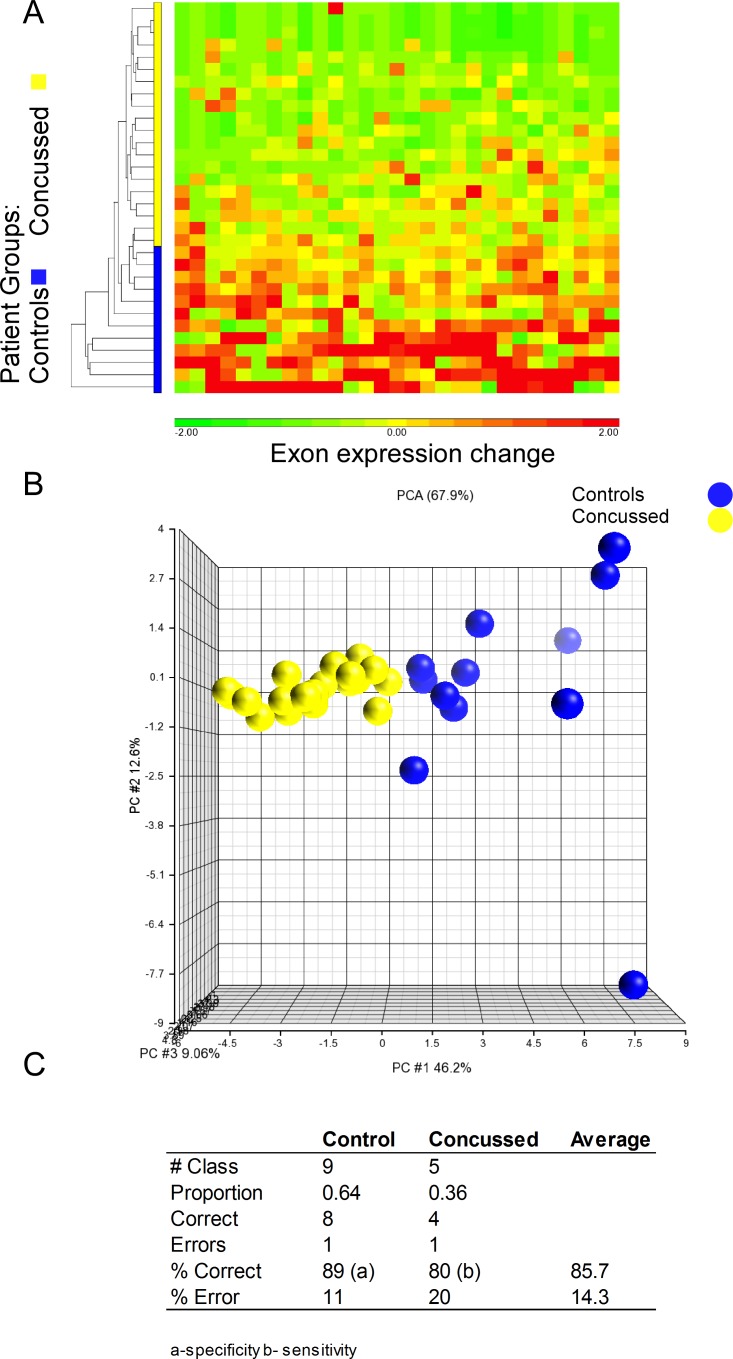
Exon expression pattern of concussion predicts clinical diagnosis.A. Hierarchical clustering shows pattern of separation between concussed and controls based on expression of 29 exons (x-axis) B. Principle component analysis plot shows the exon expression patterns separate due to concussion status. C Results of testing SVM generated model of 25 exons (Table 2) on testing data set, using a diagnosis of PCS/ concussion as the positive call. Note the accuracy was 86%, sensitivity 80% and specificity of 89%.